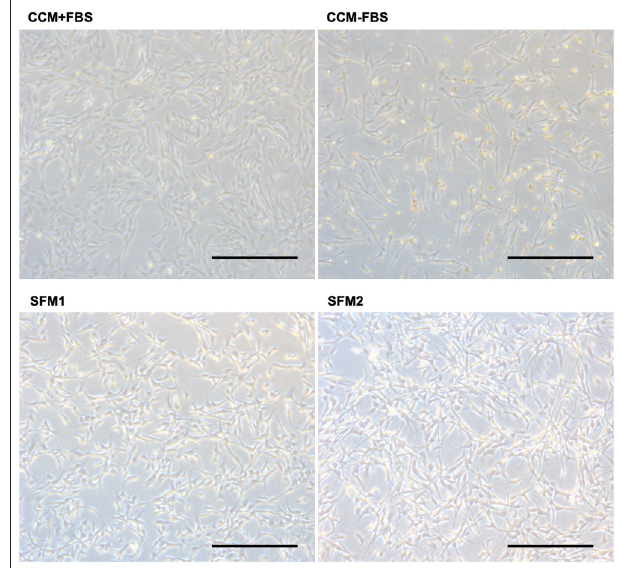
FIGURE 1 | Photomicrographs of canine MSCs. Representative photomicrographs of canine MSCs cultured in CCM + FBS, CCM–FBS and two kinds of SFM; SFM 1 and SFM 2. Canine MSCs were dead and floated in the CCM–FBS. Bars = 400 µ